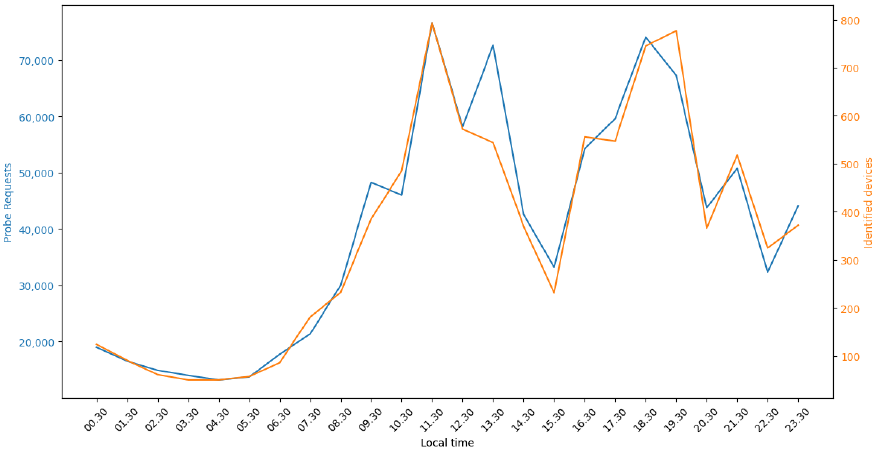
Figure 7. HourlynumberofcollectedPRsandidentifieddevicesforonedayatPiazzadelDuomo,